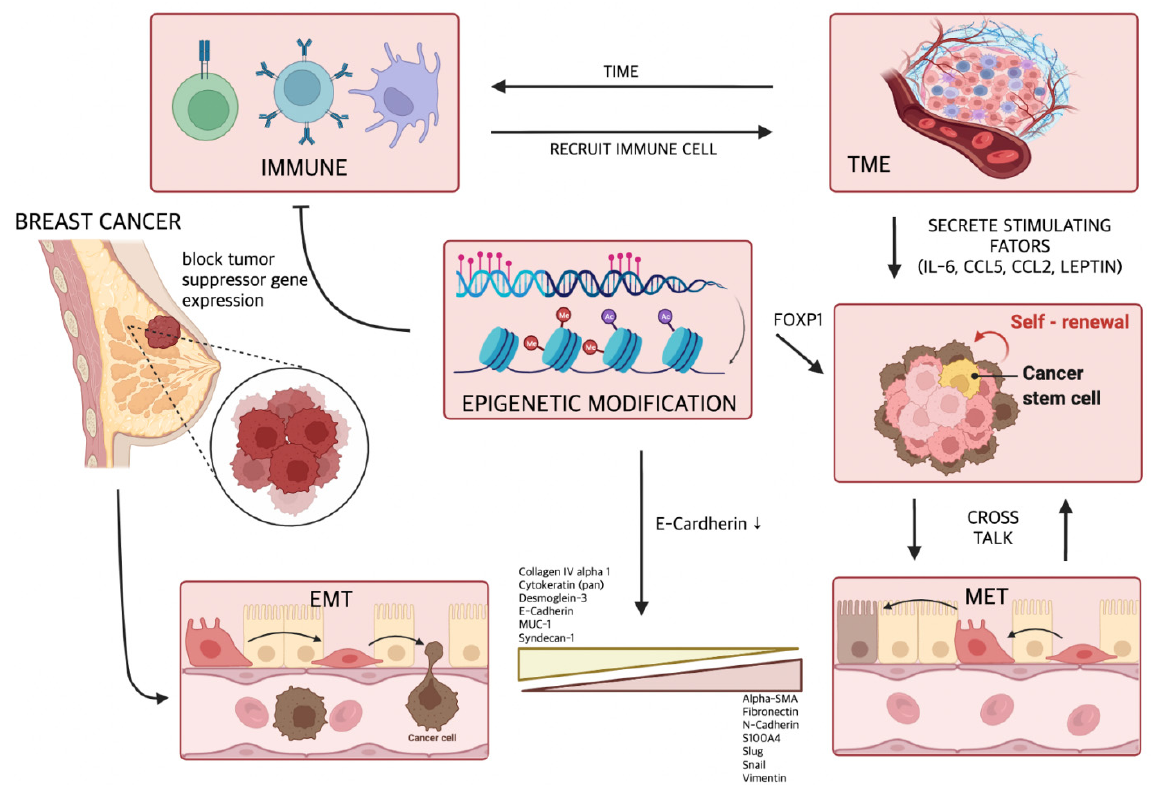
Figure 2. The various mechanisms and factors inducing the metastasis of breast cancer. Induction of EMT is directly related to the metastasis of breast cancer. In addition, multiple cytokines secreted by TME and epigenetic modification promote breast cancer metastasis by maintaining and expanding cancer stem cells with drug resistance and metastatic potential.